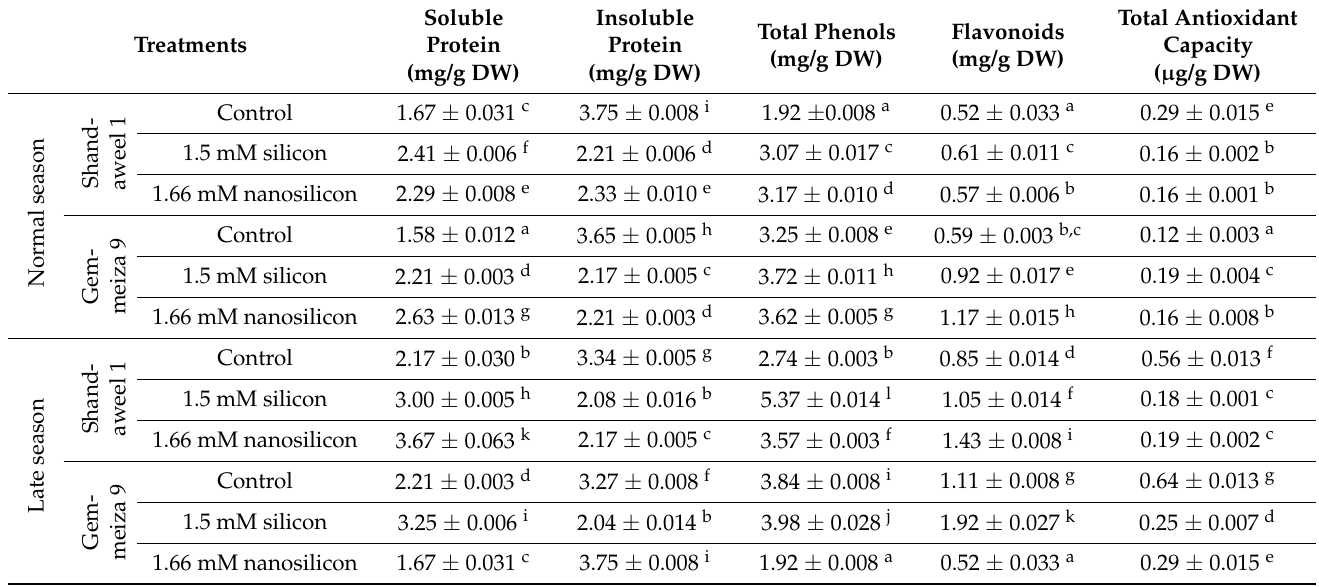
Table 8. Effects of silicon and nanosilicon on the straw yield quality of two wheat cv. Shandaweel 1 and cv. Gemmeiza 9 at normal and late seasons. Each value is the main of three different replicates ±